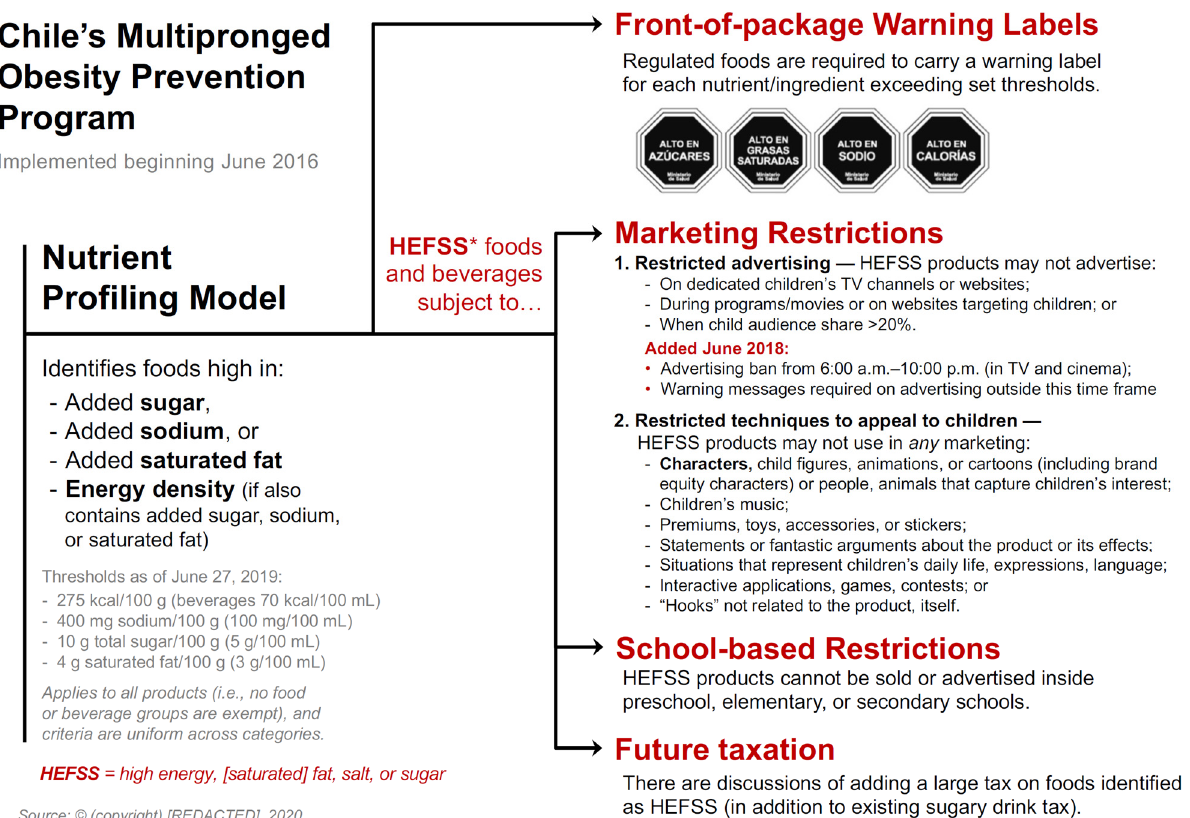
Figure 1. Chile’s multipronged Obesity Prevention Program. * HEFSS: high energy, (saturated) fat, salt, or